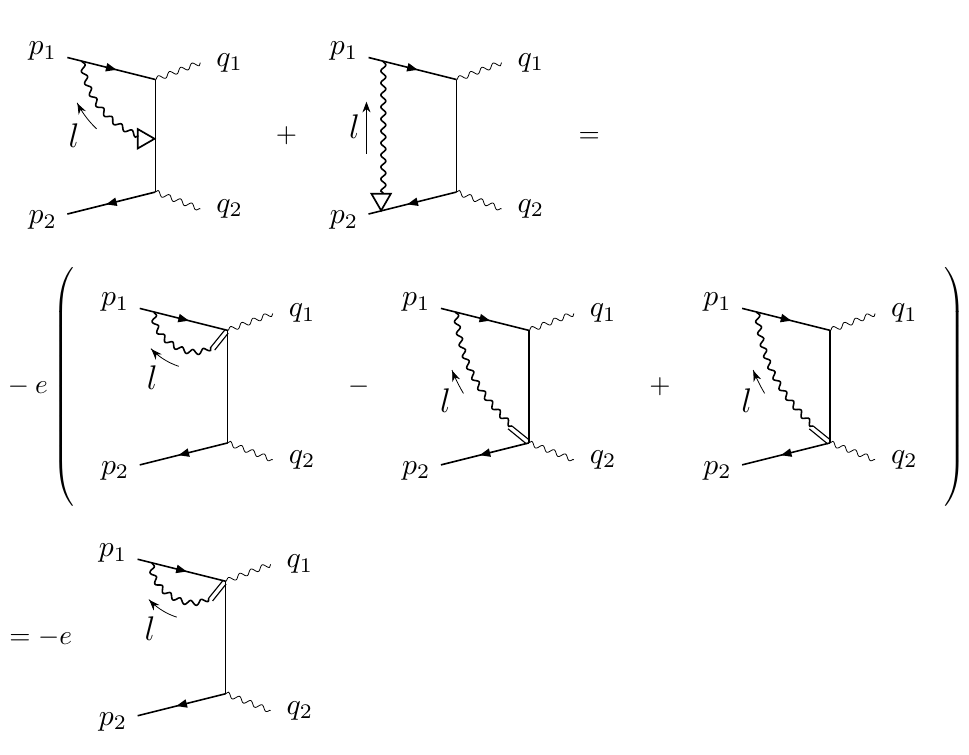
Figure 5. The application of Ward identities to factorize the l k p 1 collinear divergence in the case of two-photon production. This is a graphical representation of eq.